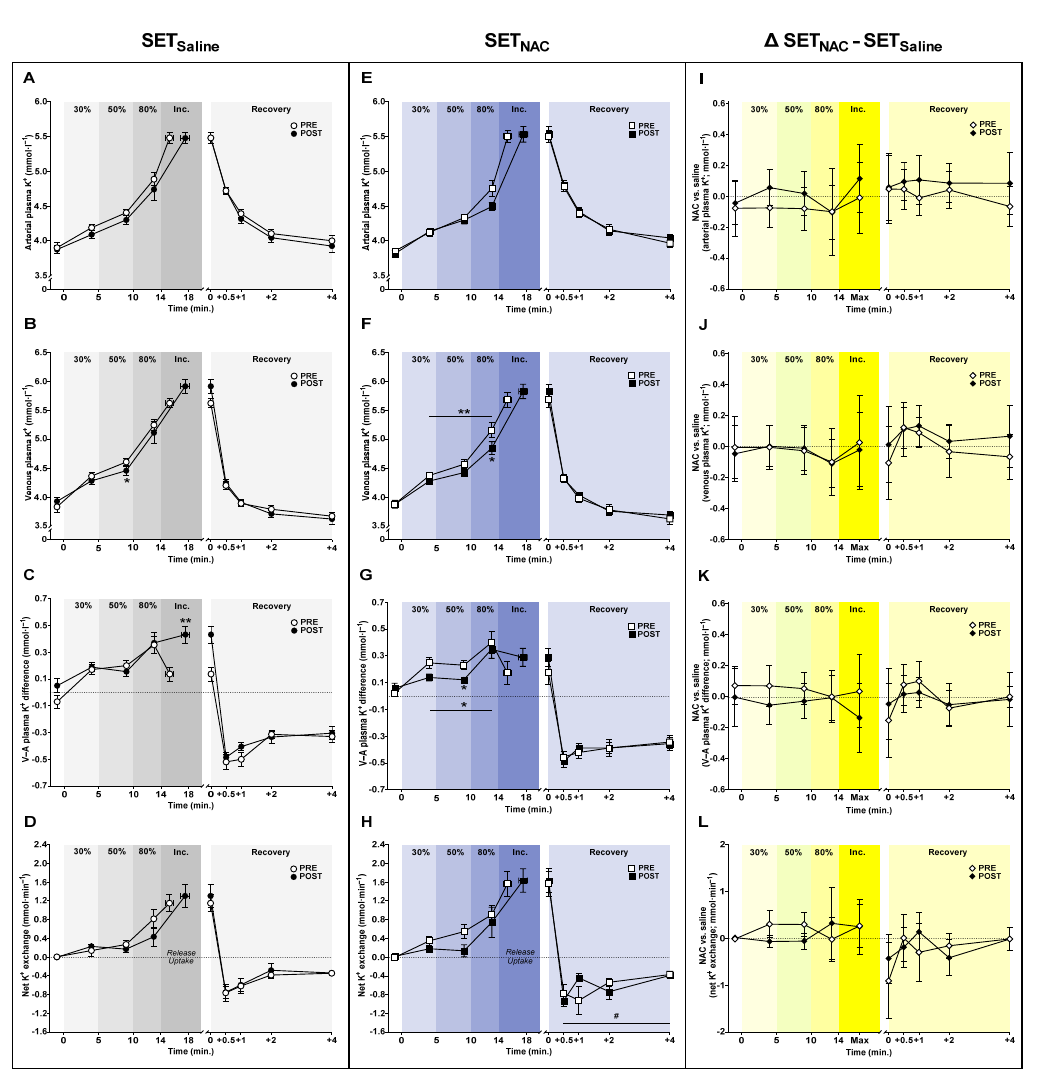
Figure 7. Effect of speed endurance training (SET) on plasma K + shifts without and with N -acetylcysteine infusion. Plasma K + concentrations ( A – C , E – G ) and net leg K + exchange ( D , H ) before, during, and after knee-extensor exercise without (SET Saline , n = 10) and with N -acetylcysteine (SET NAC , n = 9) infusion as well as differences ( Δ ) between SET NAC and SET Saline ( I – L , n = 9) before (pre) and after (post) SET. ** Post different from pre ( p < 0.01). * Post different from pre ( p < 0.05). # Trial × time effect ( p < 0.05). Data are presented as mean ± SEM (SET Saline and SET NAC ) or mean ± 95% CI ( Δ SET NAC − SET Saline ).